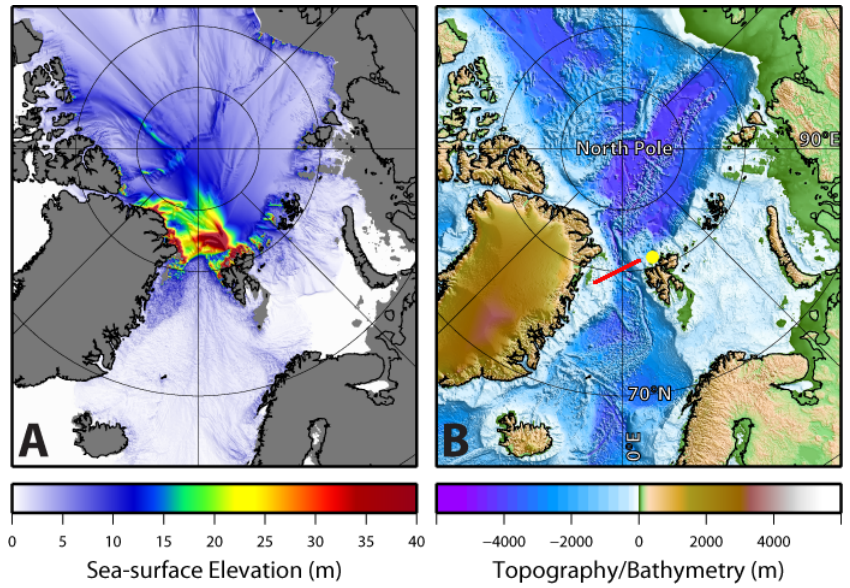
Fig. 12. The tsunami after the Hinlopen submarine landslide. Panel A shows the maximum surface elevation of the generated tsunami. Values above 40 m are colored red. The bathymetry is shown in panel B, where the initial posistion of the landslide (yellow point) and the transect for figure 13 (red line) are shown. The figure is modified from Vanneste et al. (2011).